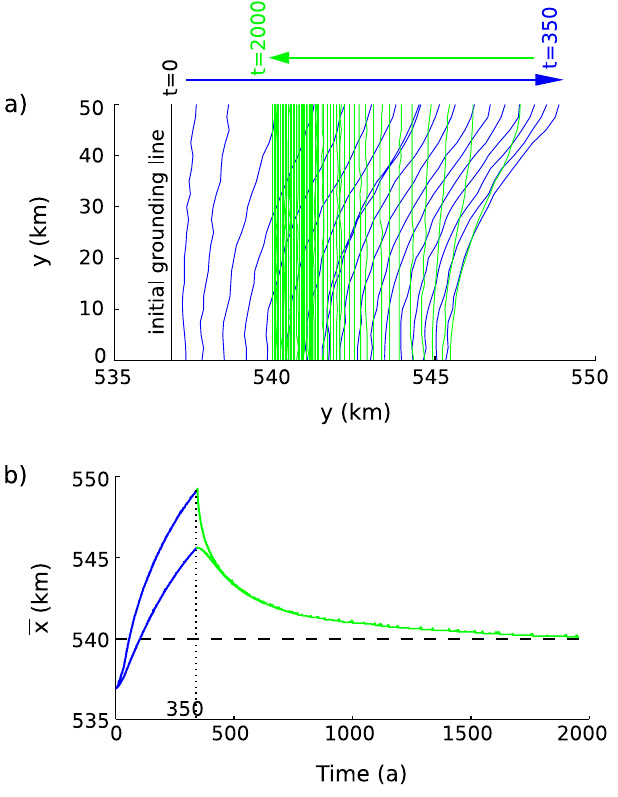
Fig. 5. Migration of the grounding line over time (the corresponding averaged velocities are shown in Fig. 6) for the verification exper- iment (see Table 2). Advance and retreat processes are shown in blue and green, respectively. (a) Top view in the (x,y) plane. (b) Positions of the main grounding line for y = 0 and y = 50 km. The new grounded area created by the pinning point is not shown in this figure.